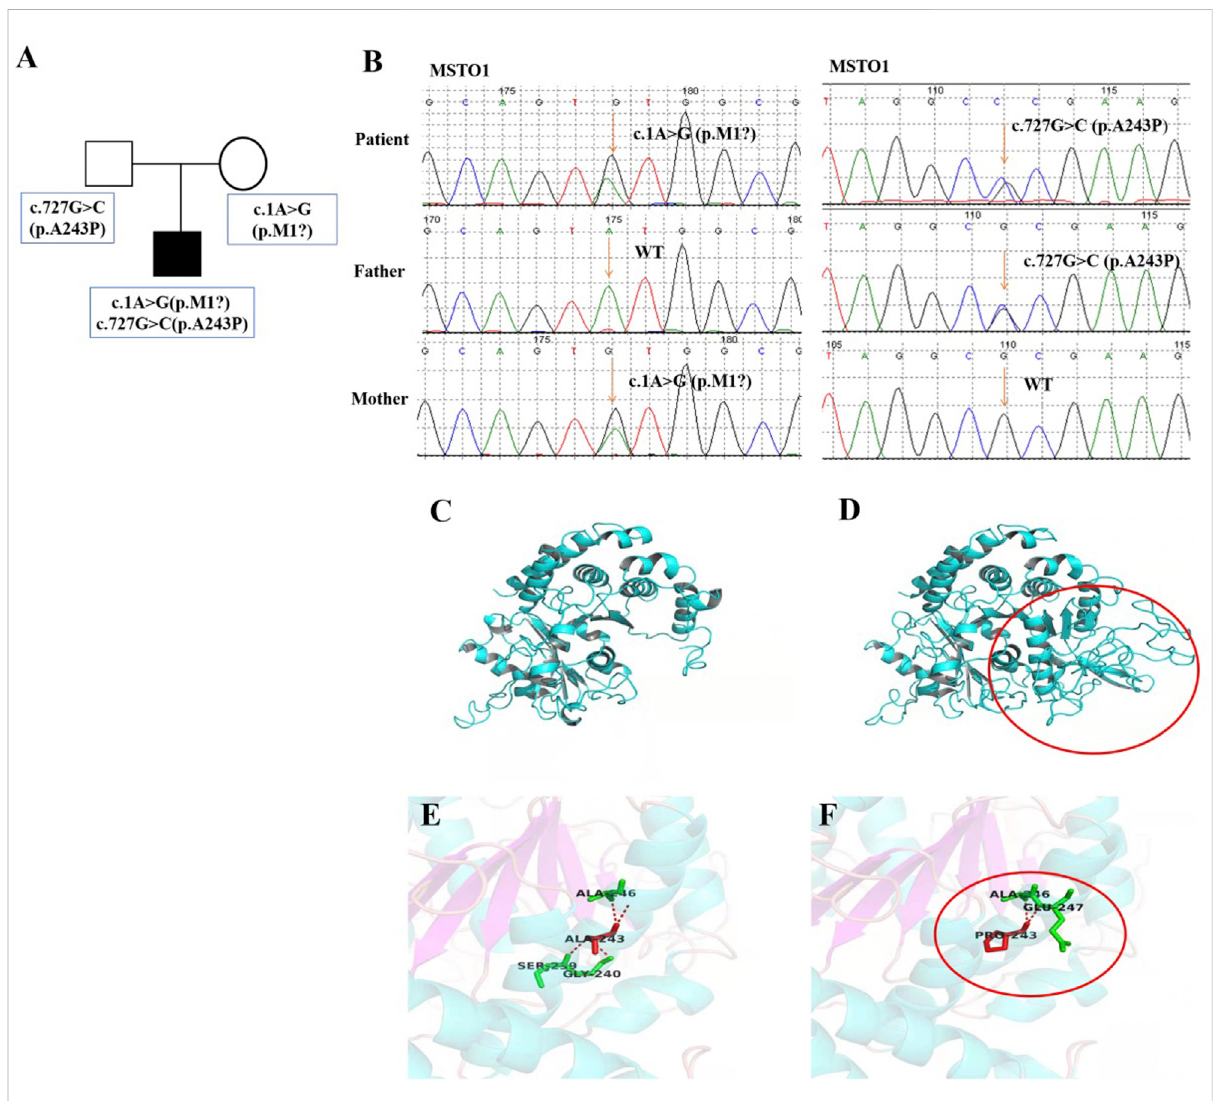
FIGURE 3 Pedigreefeaturesofthepatientwith MSTO1 variant. (A) Pedigreewiththeidenti fi edacompoundheterozygousMSTO1variants. (B) Sequencing veri fi cation results showed two heterozygous variants c.1A > G (p.M1?) and c.727G > C (p.A243P) of the MSTO1 gene were inherited from his parents respectively. c.1A > G variant was located at the fi rst position of the coding sequence, which affected the start codon, and led to abnormal protein structure aftervariant, especiallyintheloop structureregion.c.727G > C variantcould induceareduction inthenumberofassociatedhydrogen bonds between the interior of the protein of the 243rd position and other amino acids from 4 to 2, which was predicted to also affect the protein structure (D,F)